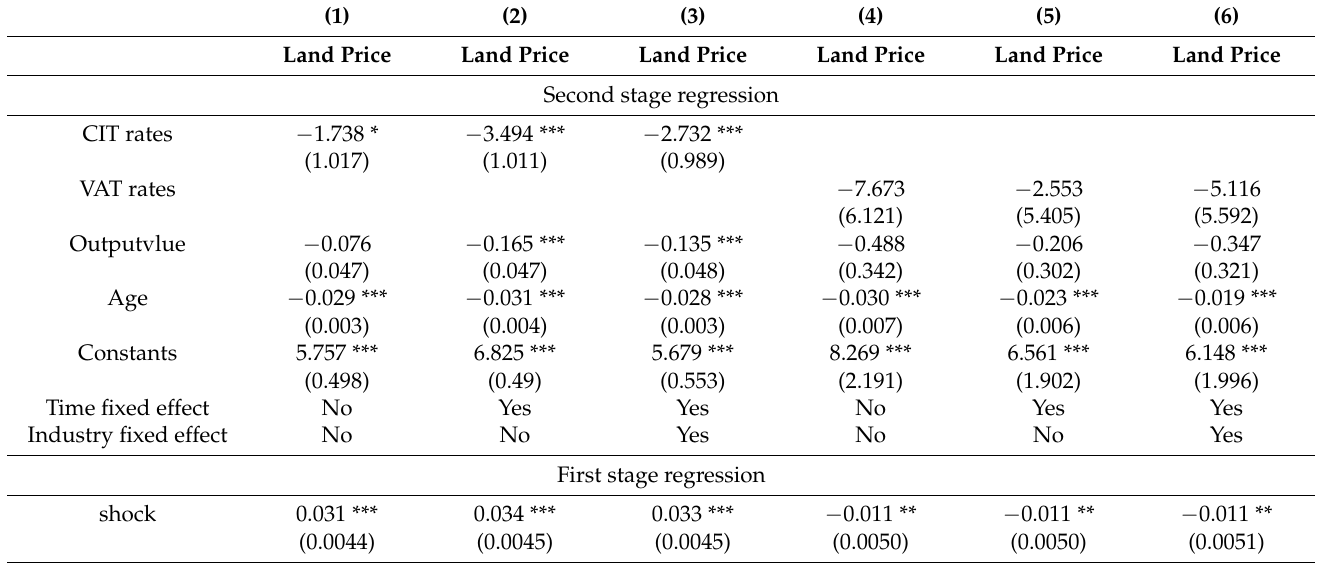
Table 3. Mechanism: Impact of the reform on the effective tax rates and land prices by using 2SLS.